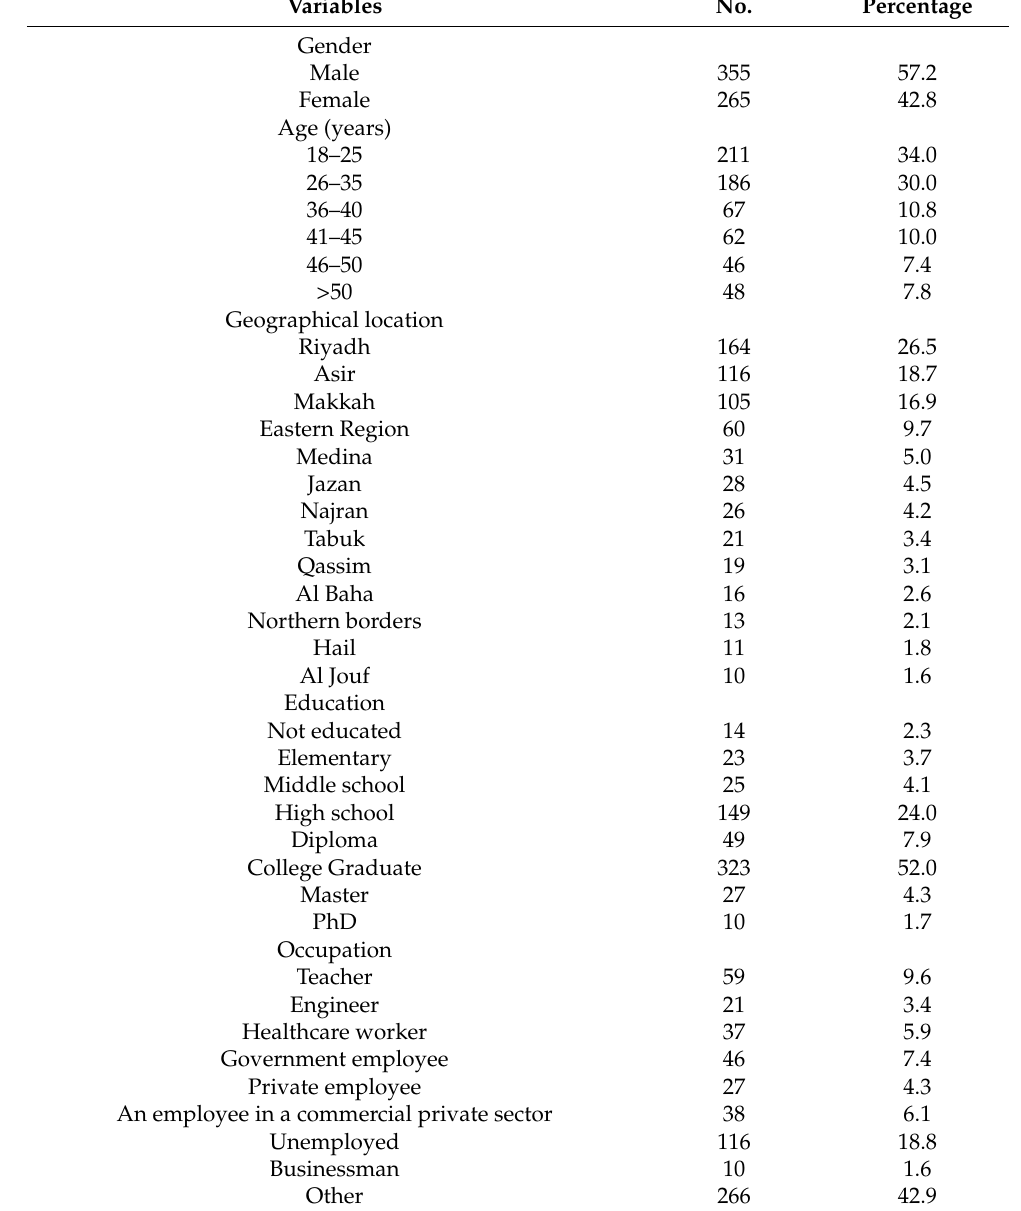
Table 1. Socio-demographics characteristics of participants ( n =